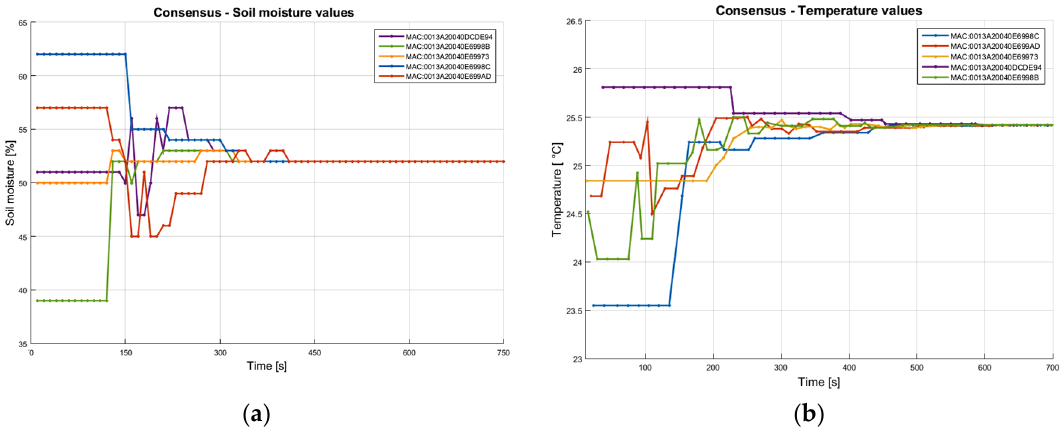
Figure 18. Consensus results for: ( a ) soil moisture and ( b ) air temperature.